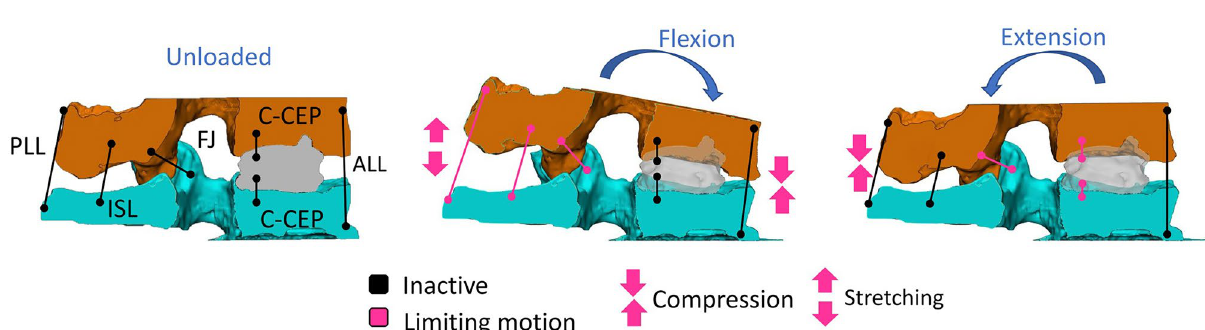
Figure 7. Correlation between the volume of cement injected and the foramen volumetric change induced by PCD: in flexion ( A ), and extension ( B ). Linear regression is plotted for all data.